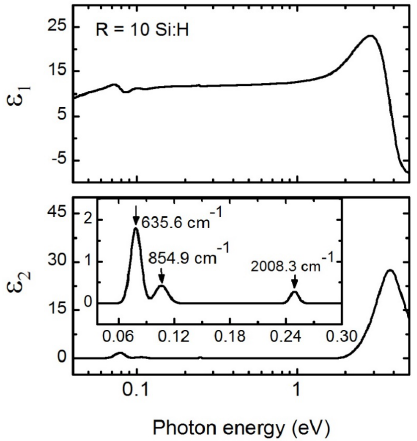
extraction of physically realistic ε . Parameters describing spectra in ε for the underlying n ‐ layer were extrapolated based on previously observed trends in the Cody ‐ Lorentz oscillator parameters with temperature [73].